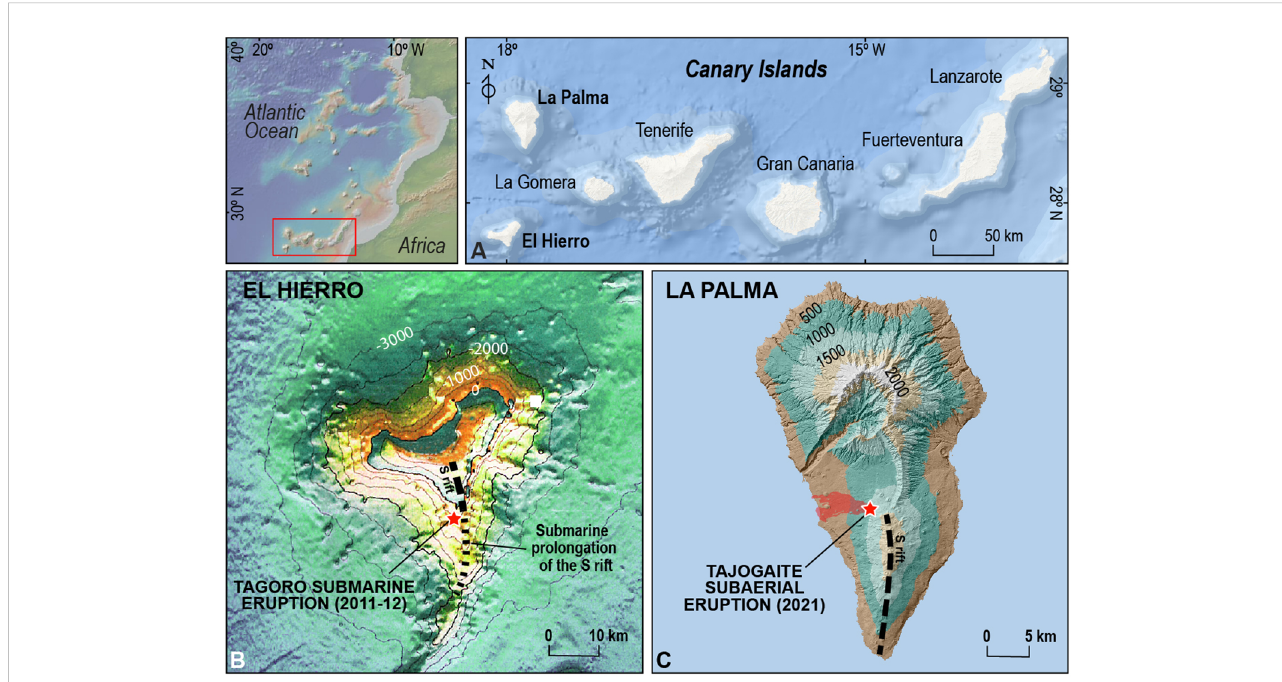
FIGURE 1 Location of the Canary Islands in the framework of the Central Atlantic Ocean (A) . Location of the Tagoro eruption in the submarine prolongation of the S rift of the island of El Hierro (B) . Location of the Tajogaite eruption in the western fl ank of the S rift (Cumbre Vieja rift) of the La Palma island. The perimeter of the lava fi eld with the entrance to the sea is marked in red (C)